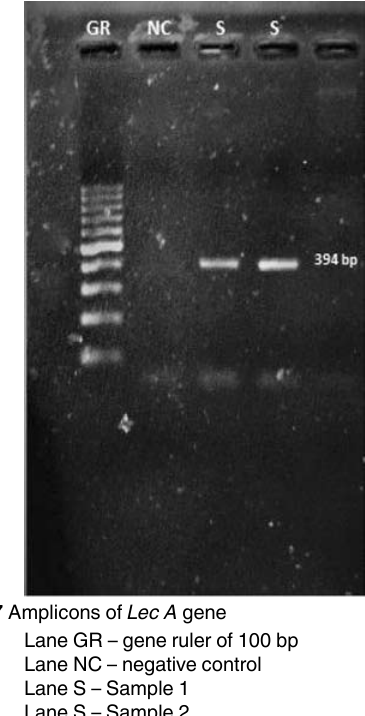
Kerala Veterinary and Animal Science University for the amenities provided for this study. Conflict of interest